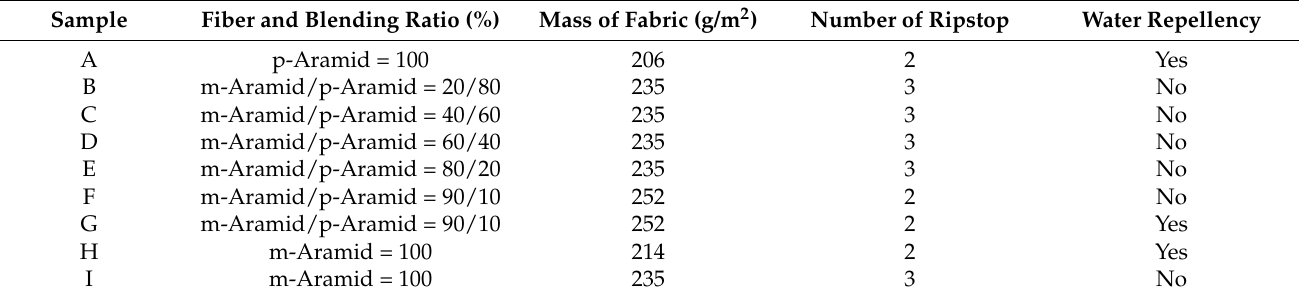
Table 1. Specification of the test